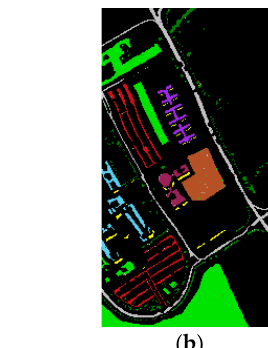
Shadows, Meadows, Bricks, Bare soil; ( c , d ) AVIRIS Indian Pines dataset, Alfalfa, Meadows, Bricks, Bare soil; ( c , d ) AVIRIS Indian Pines dataset, Alfalfa,